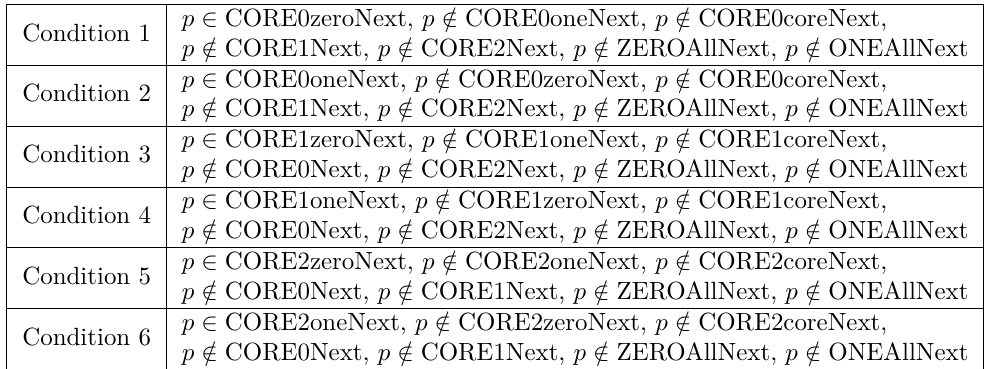
Table 3: Conditions to determine a candidate